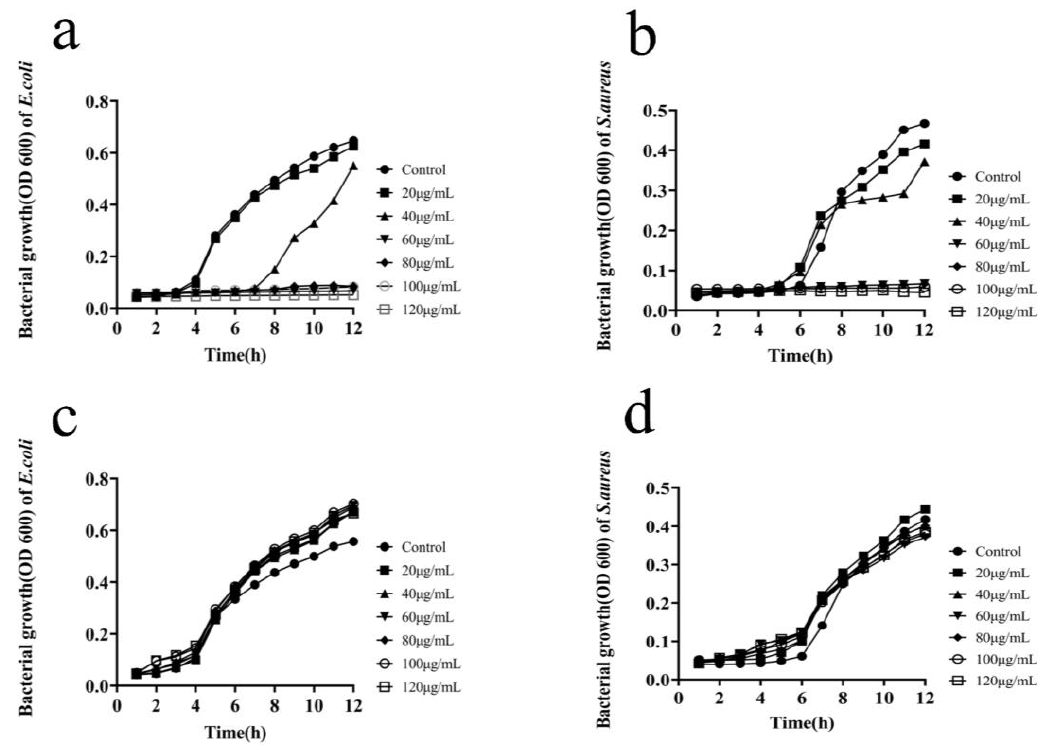
Figure 12. Bacterial growth curves of MIL-101(Fe) and MIL-101(Fe)@Ag (Ag 0.0127 wt%) for inhibi- tion of E. coli and S. aureus growth. ( a ) Bacterial growth curve of inhibition of E. coli growth by MIL- 101(Fe)@Ag (Ag 0.0127 wt%). ( b ) Bacterial growth curve of inhibition of S. aureus growth by MIL- 101(Fe)@Ag (Ag 0.0127 wt%). ( c ) Bacterial growth curve of inhibition of E. coli growth by MIL- 101(Fe). ( d ) Bacterial growth curve of inhibition of S. aureus growth by MIL-101(Fe).